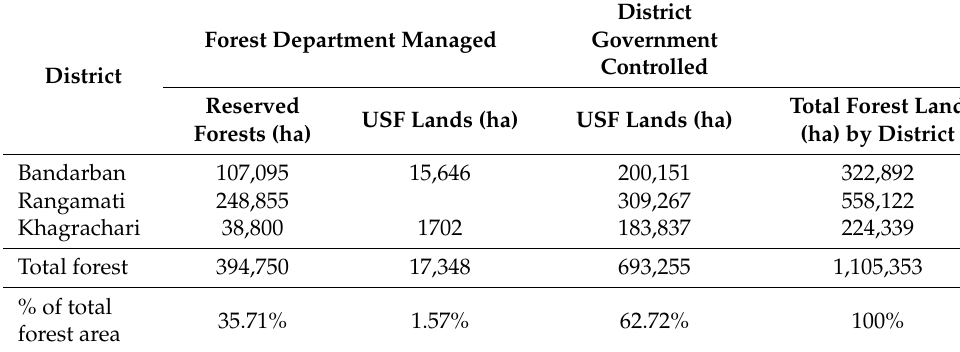
District Government Controlled (ha) by